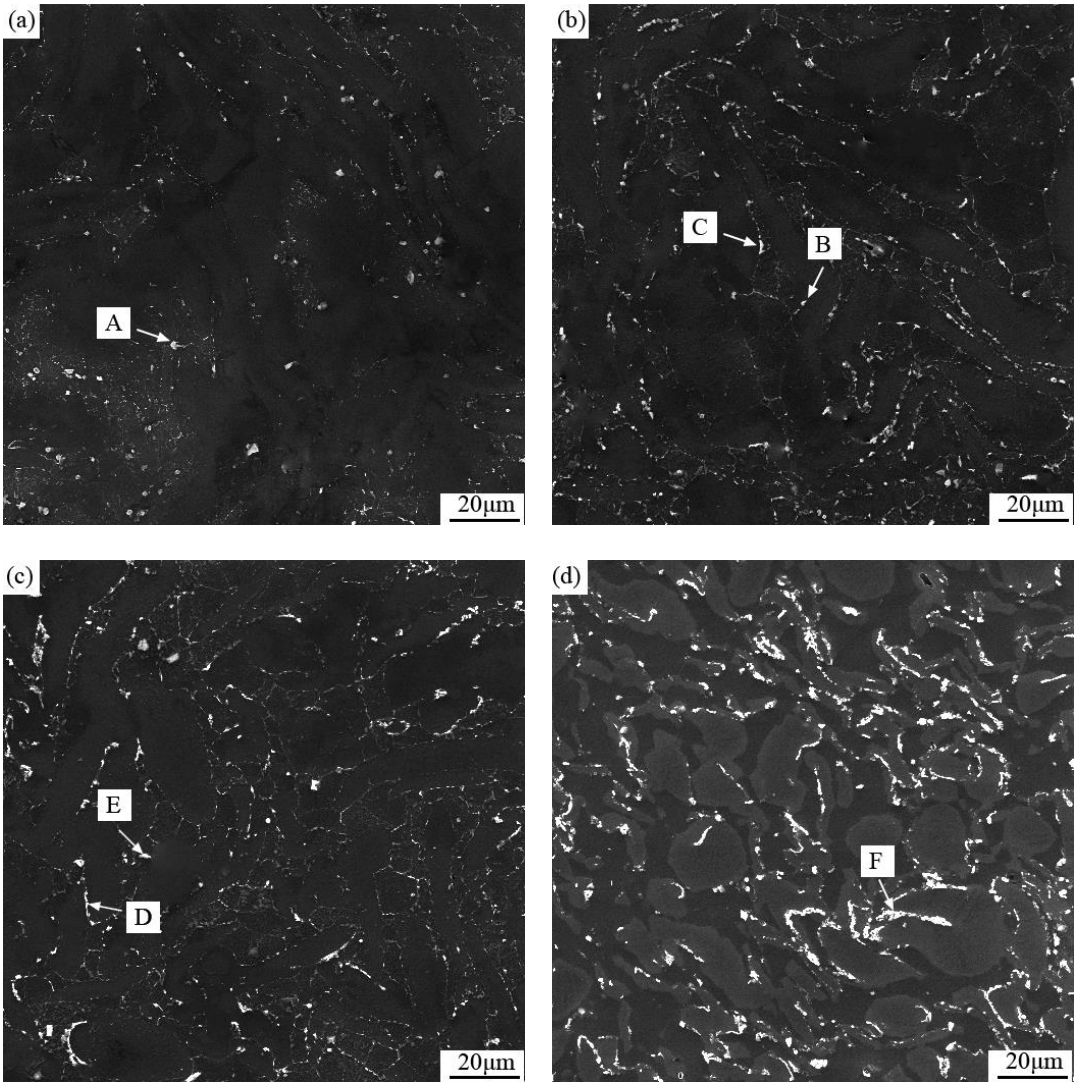
Figure 4. SEM images of the Mg–7Li–3Al–xCa alloys: ( a ) x = 0 ( b ) x = 0.4 ( c ) x = 0.8 ( d ) x = 1.2. Table 2. EDS result corresponding to different positions in Figure 4. (mole fraction, %).